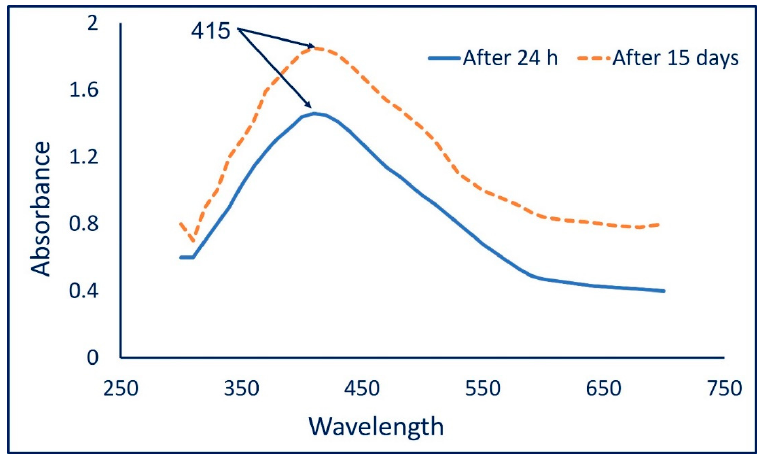
Figure 1. UV-Vis spectroscopy of biosynthesized Ag-NPs at different times (after 24 h and 15 days) referred to no change in SPR peak.